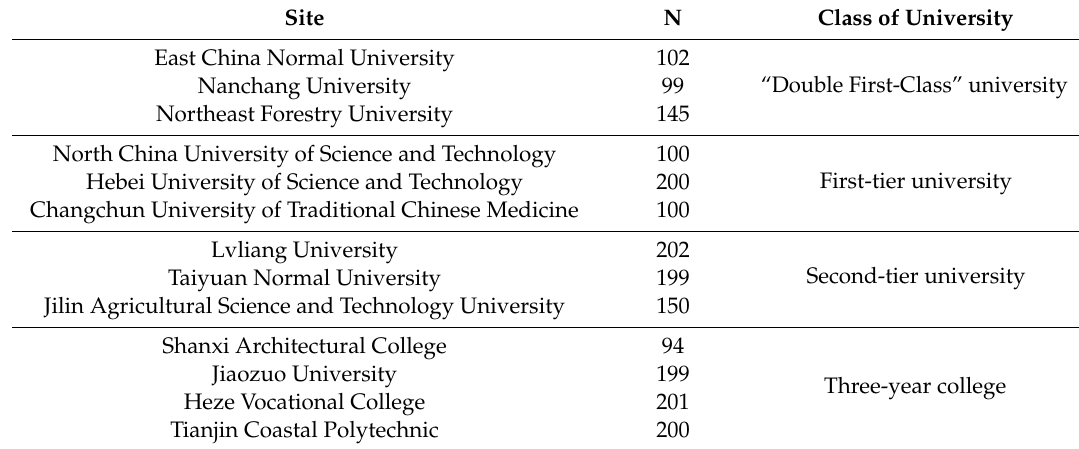
Table 1. Samples of the universities and three-year colleges in China in the survey of attitudes toward sustainable wildlife management (SWM) and wildlife